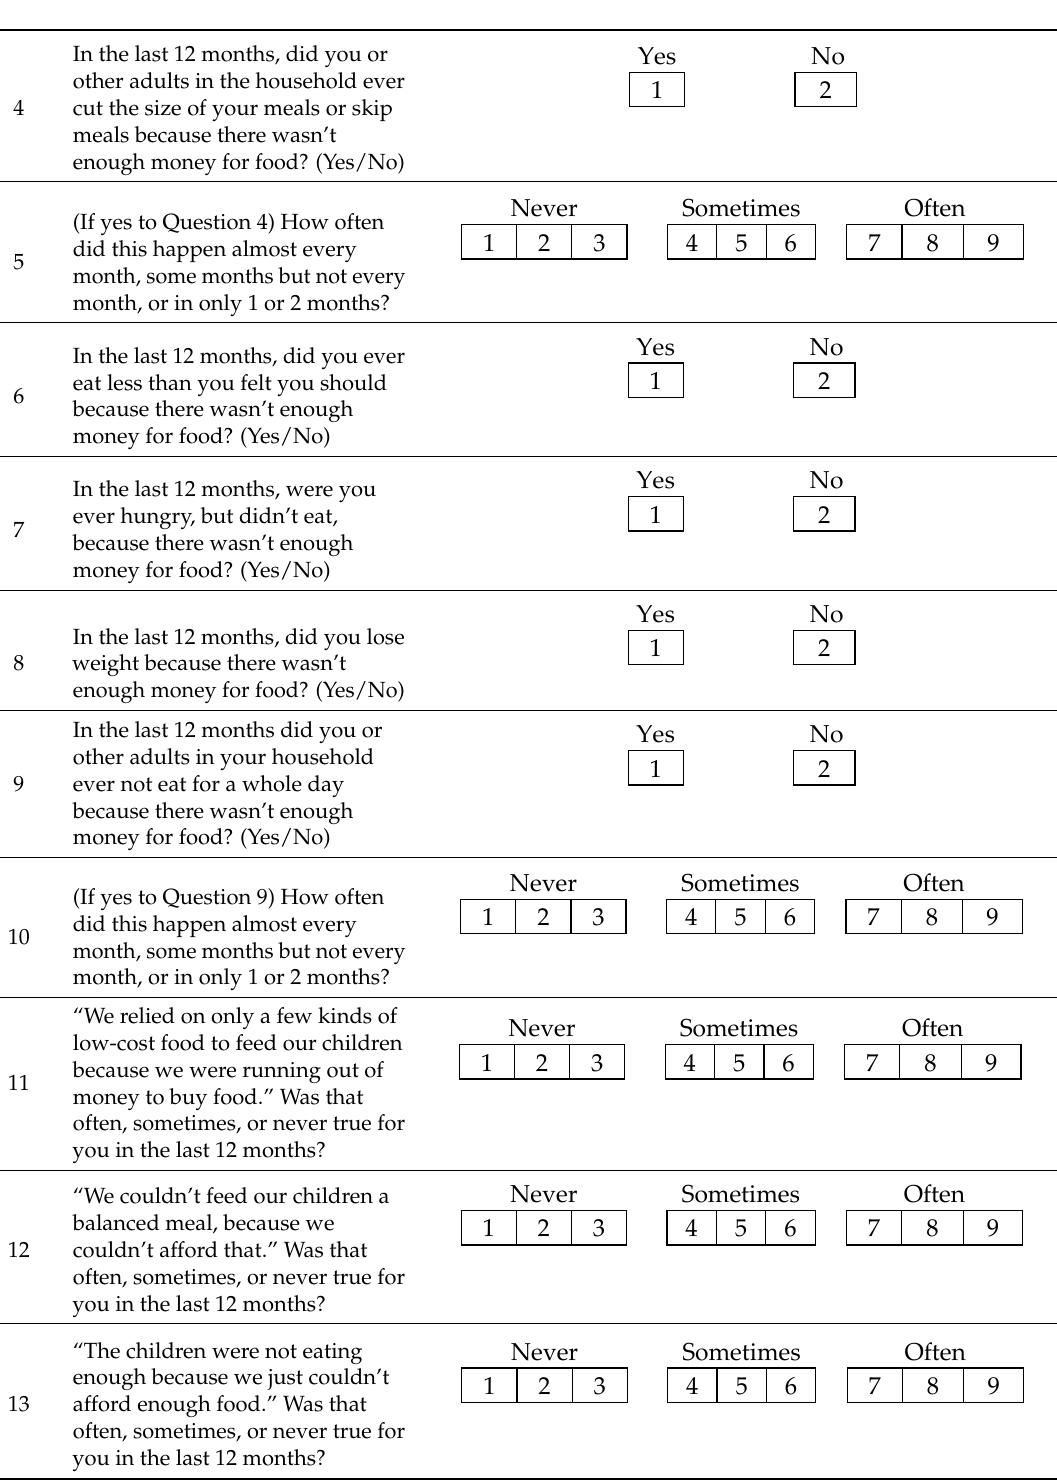
Table A1. 18-Question Core Food Security